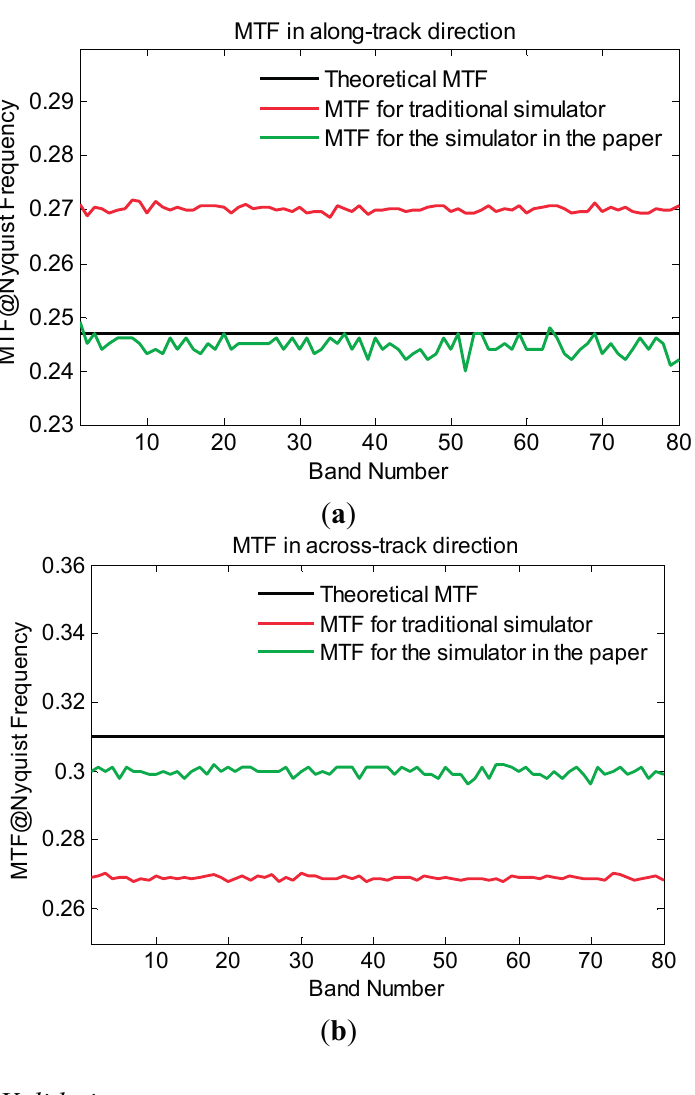
Figure 7. The MTF (Nyquist frequency) calculated from the simulated edge scenes for the traditional simulator and the proposed simulator. ( a ) MTF in along-track direction; ( b ) MTF in across-track